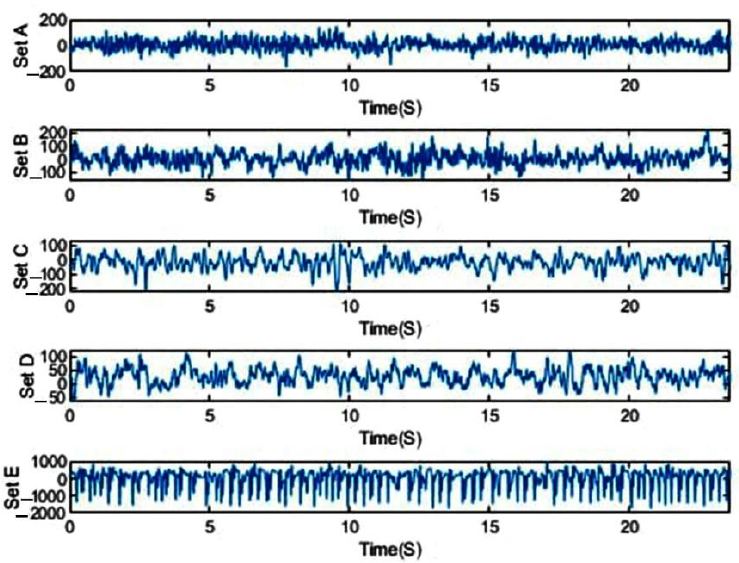
Figure 2. Exemplary EEGs from five samples of the Bonn dataset. Table 4. Further details about the Freiburg